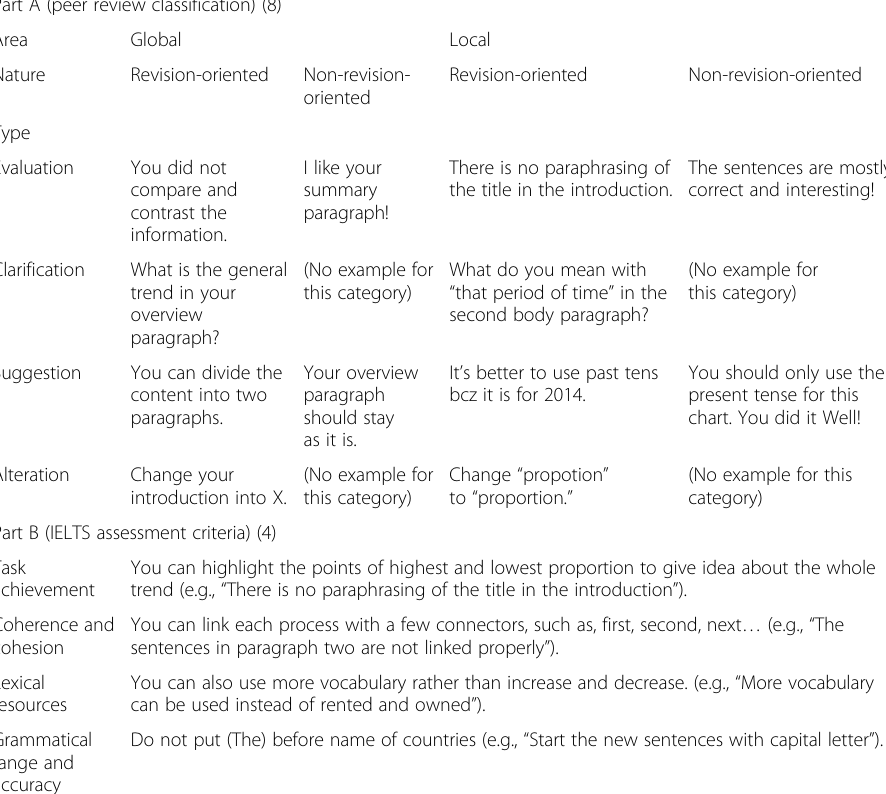
Table 3 The analytical scheme for classifying peer comments Part A (peer review classification)